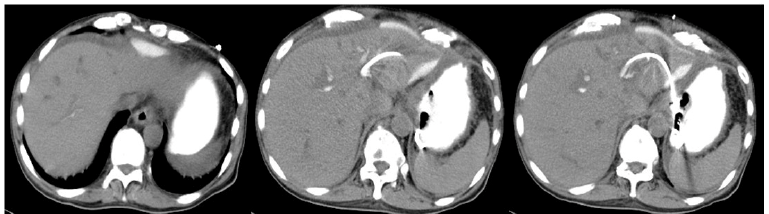
Figure 2. CT scan image showing bile leak. Contrast medium is filling the stomach. Leakage of contrast medium can be seen near the stenting site.